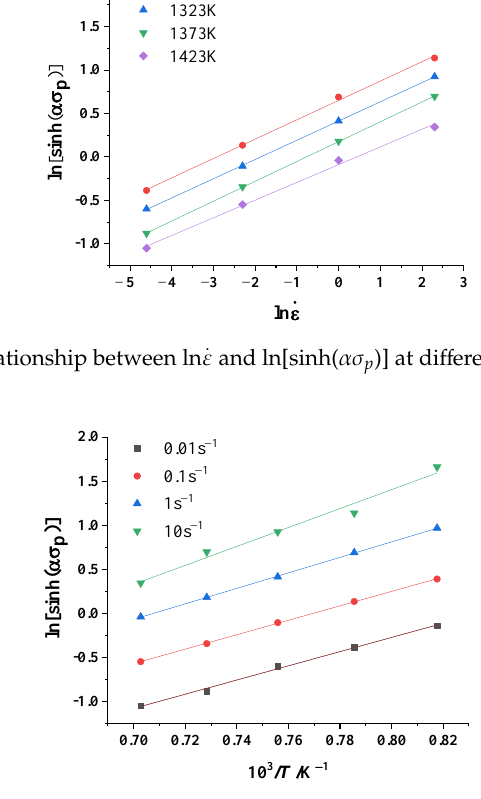
Figure 4. Relationship between and ln[sinh( αp )] at different temperatures.